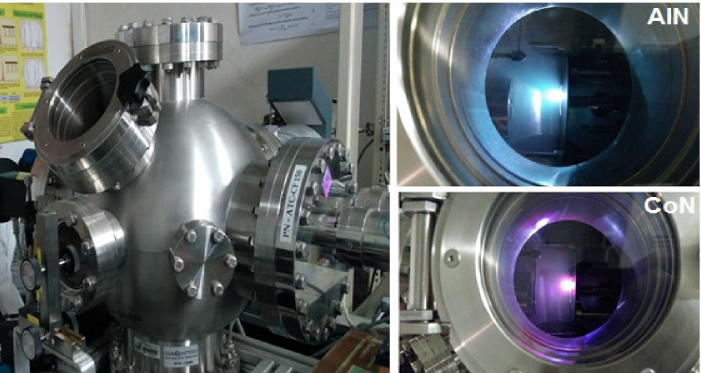
Figure 1. Image associate to PLD (pulsed laser deposition) device and the experimental processes used for the deposition of coatings by means of